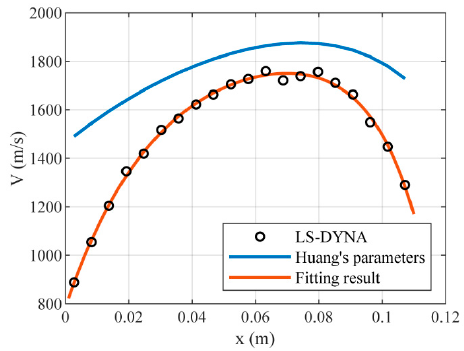
Figure 3. Initial velocity fitting result.